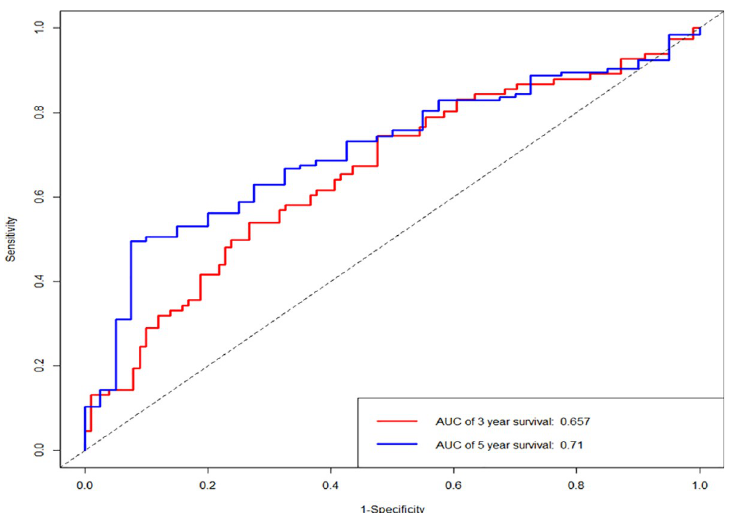
Fig 4. ROC curve. The ROC curve of the miRNA signature for 3-year and 5-year survival probability in the combined cohort. ROC, receiver operating characteristic; miRNA, microRNA.